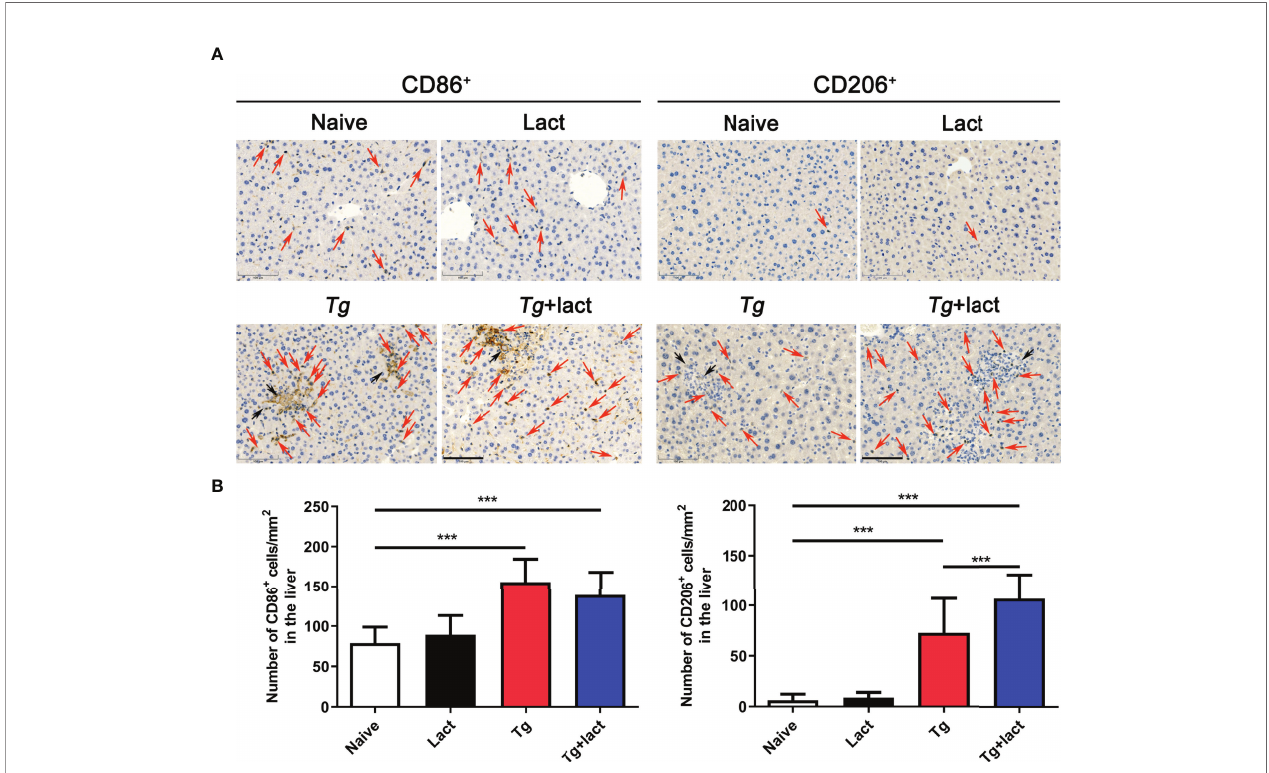
FIGURE 8 | Immunohistochemical staining for CD86 + and CD206 + cells in the livers of mice from different groups. (A) Immunohistochemical staining of CD86 + and CD206 + cells were labeled by CD86 mAb and CD206 pAb, respectively. Red arrows indicate positive cells and black arrows indicate tachyzoites. Original magni fi cation 200× (scale bar = 100 µm). (B) Morphometric analysis showed the number of CD86 + or CD206 + cells per square millimeter in the liver tissues. Data are presented as means ± SD; experiments were performed with four mice per group. *** P <